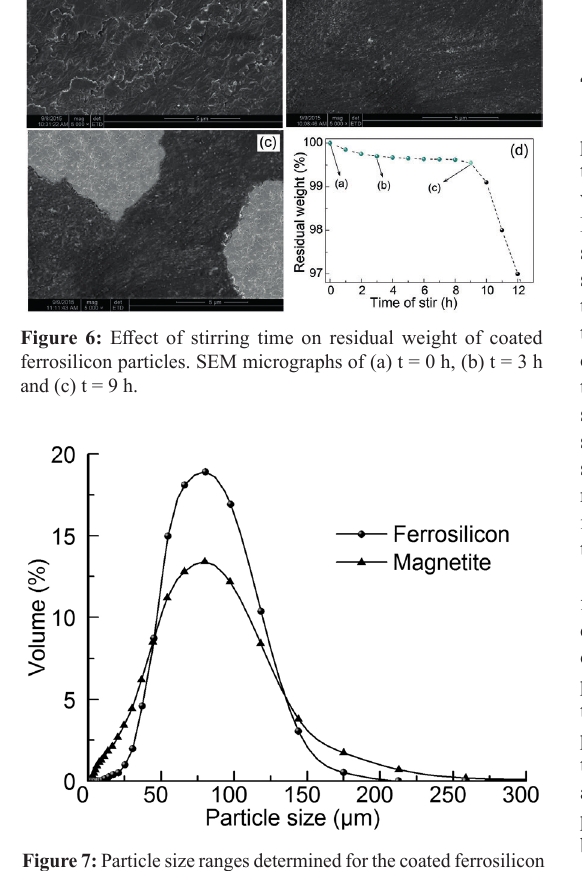
Figure 7: Particle size ranges determined for the coated ferrosilicon particles and magnetite important role in the apparent viscosity of two suspensions, especially when the medium density is greater than 2.2